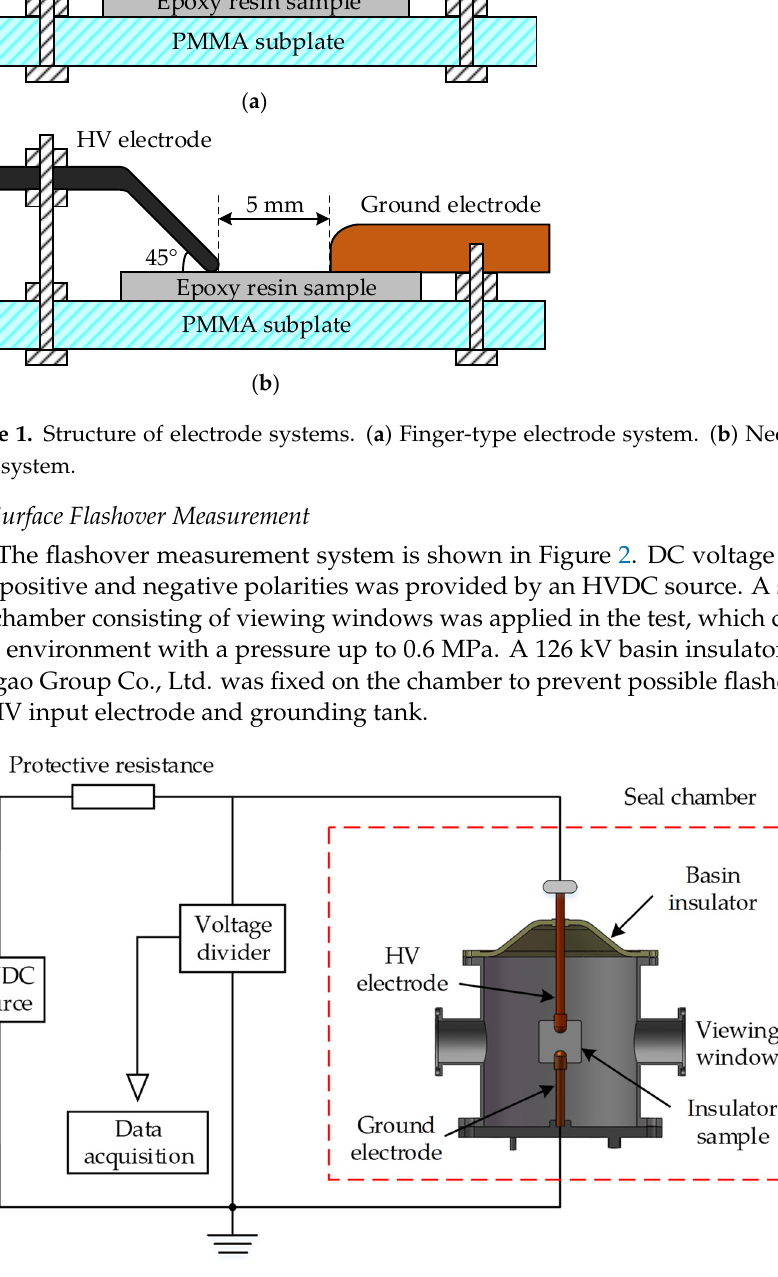
Figure 2. Experimental setups for the surface flashover test.